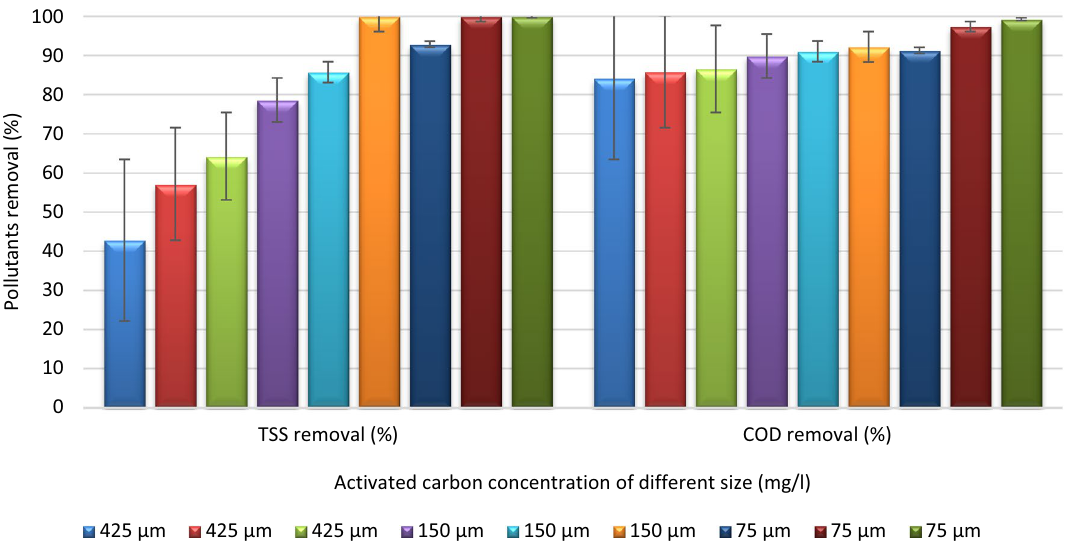
Fig. 9 Effect of orange peels activated carbon concentration and size on removal efficiency of different